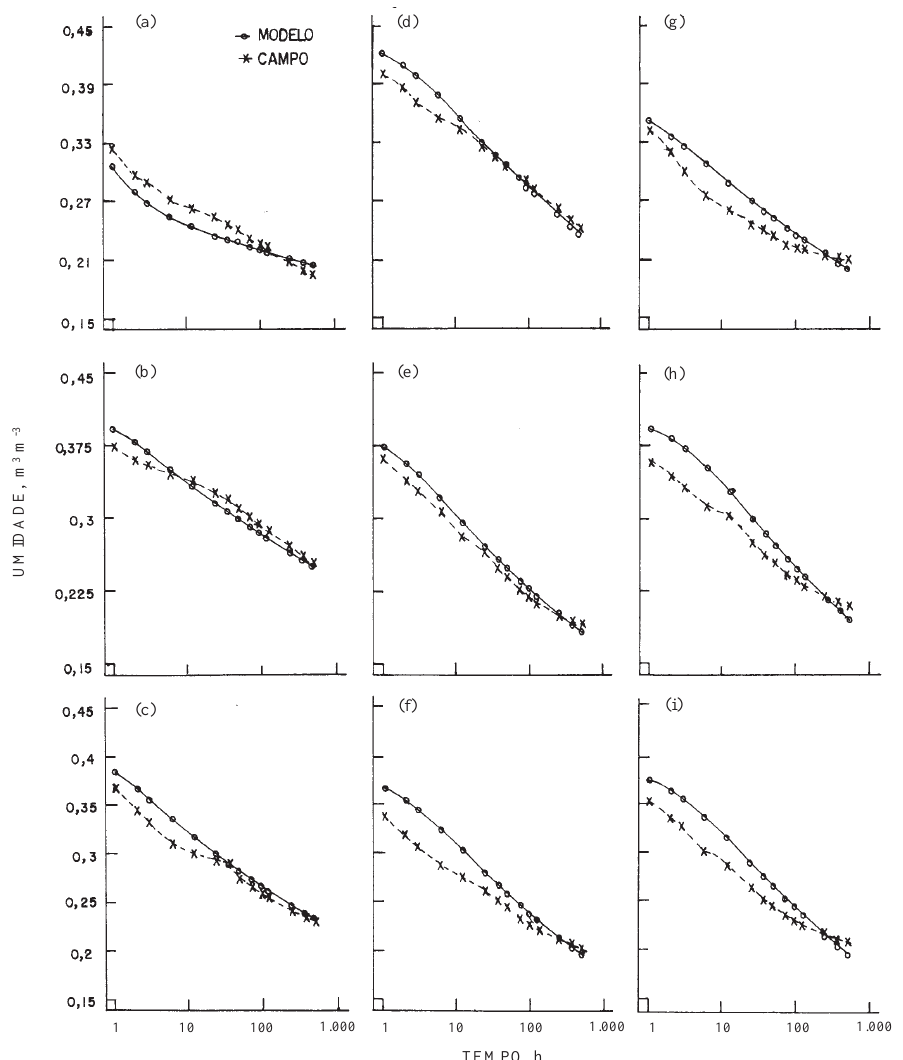
Figura 4. Perfis de umidade em função do tempo para o experimento em Latossolo Vermelho-Amarelo textura média, obtidos mediante modelo numérico de Prevedello (1996) e dados de campo de Libardi (1978). (As letras a, b, ..., i indicam as profundidades de 0,15; 0,30; 0,45; 0,60; 0,75; 0,90; 1,05; 1,20; e 1,35 m,